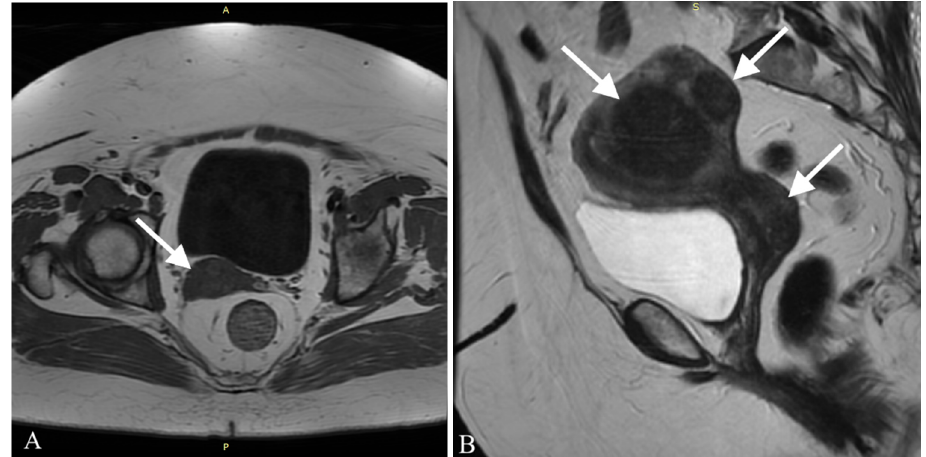
Figure 2. A preoperative MRI of the pelvis in ( A ) axial and ( B ) sagittal projection. Both show the presence of myomas in the uterus. Arrows show myomas in the